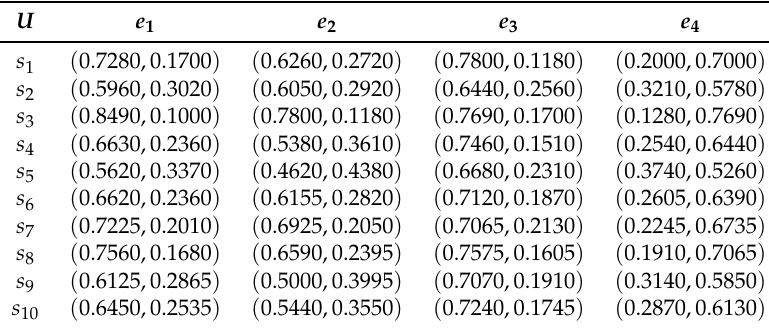
Table 5. Intuitionistic fuzzy soft set G = ( (cid:101) G , C ) = I c